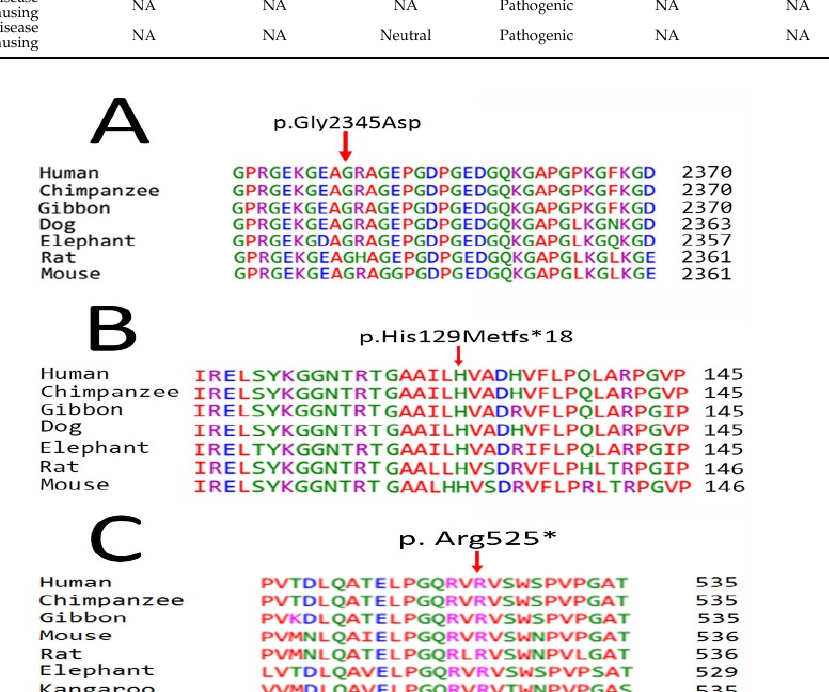
Figure 4. Multiple sequence alignment of Human Gly2345 in Family A , Human His129 in Family B and Human Arg525 in Family C with their orthologs. Red arrows showing their evolutionary conservation through different species. Table 1. Information on COL7A1 variant s .